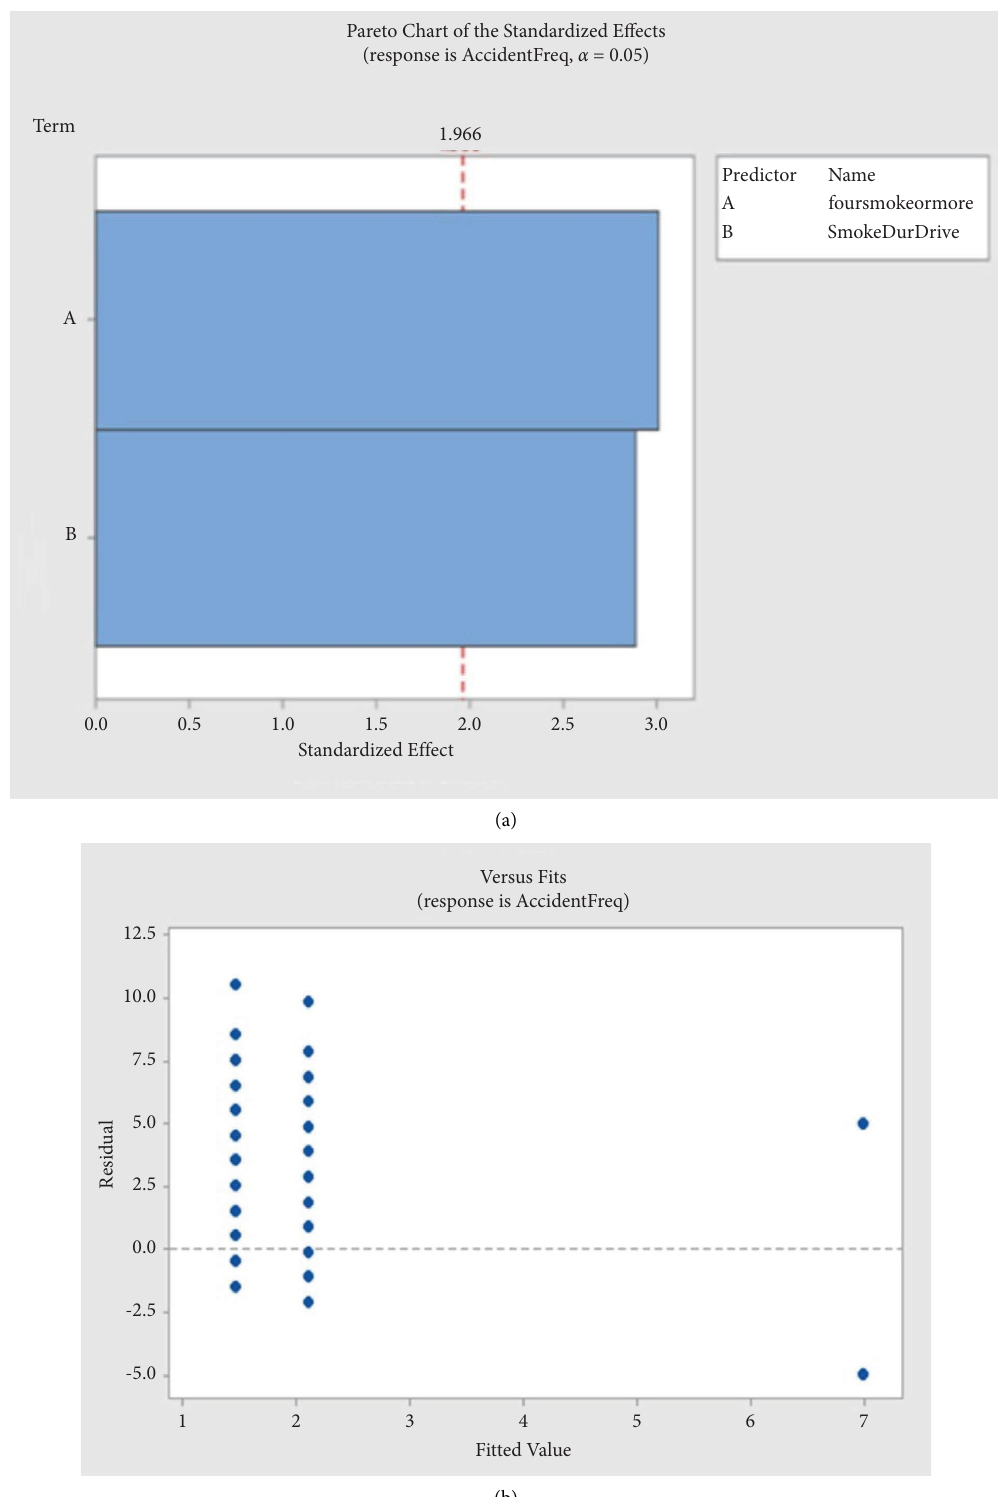
Figure 3: (a) Pareto chart of the standardized efects and (b) versus fts plot of the new regression